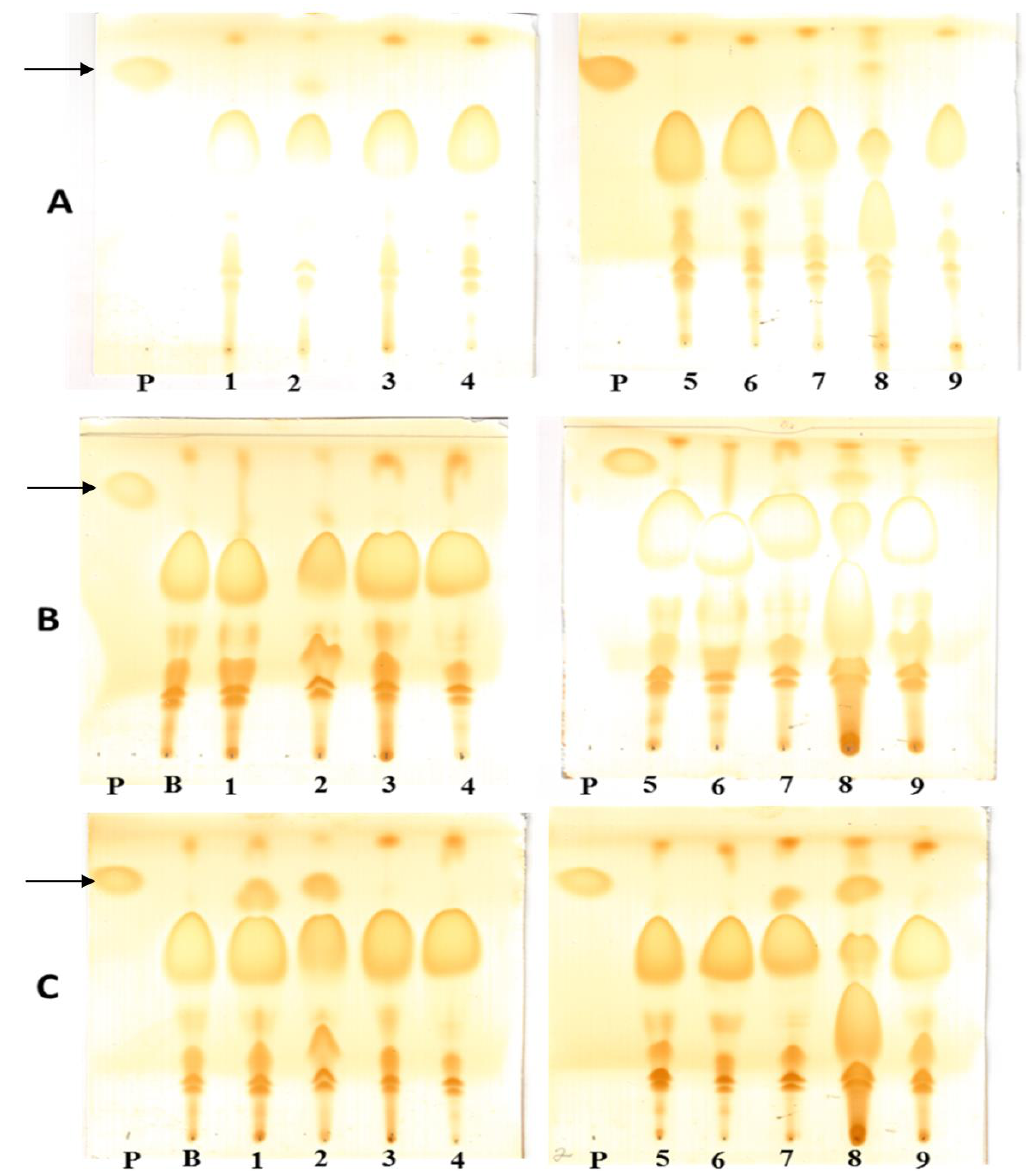
Figure 7. Transesterification assay with ethanol in different oils (black arrow). ( A ) Control ( B ) Lip1 adsorbed in octadecyl ( C ) Lip2 adsorbed on octadecyl. P = ethyl oleate 1%, B = soy oil control, 1 = soy oil, 2 = macaúba almond oil, 3 = canola oil, 4 = corn oil, 5 = pequi oil, 6 = sunflower oil, 7 = olive oil, 8 = macaúba pulp oil, 9 = sesame oil.